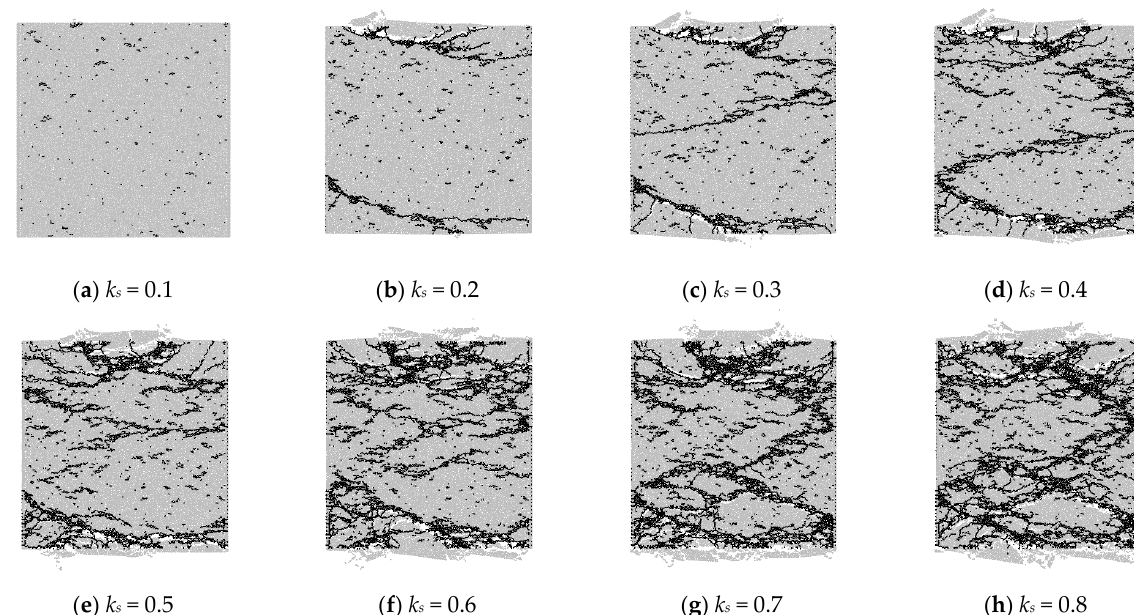
Figure 9. Failure mode of sample subject to different pre-stress levels at 4 m/s impact speed.